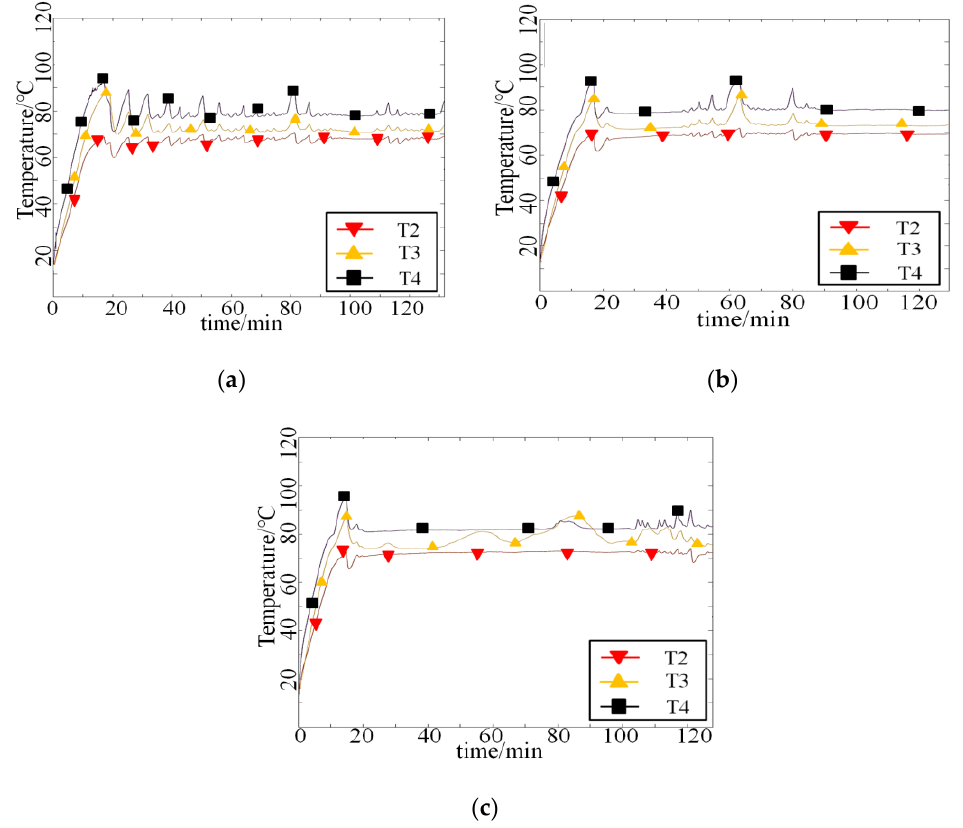
Figure 6. Temperature profile of heat flow density of 3556 ~4444 W·m −2 at an inclination angle of 90°. ( a ) q = 3556 W·m −2 , ( b ) q = 4000 W·m −2 , ( c ) q = 4444 W·m −2 . ( a ) q = 3556 W · m − 2 , ( b ) q = 4000 W · m − 2 , ( c ) q = 4444 W · m − 2